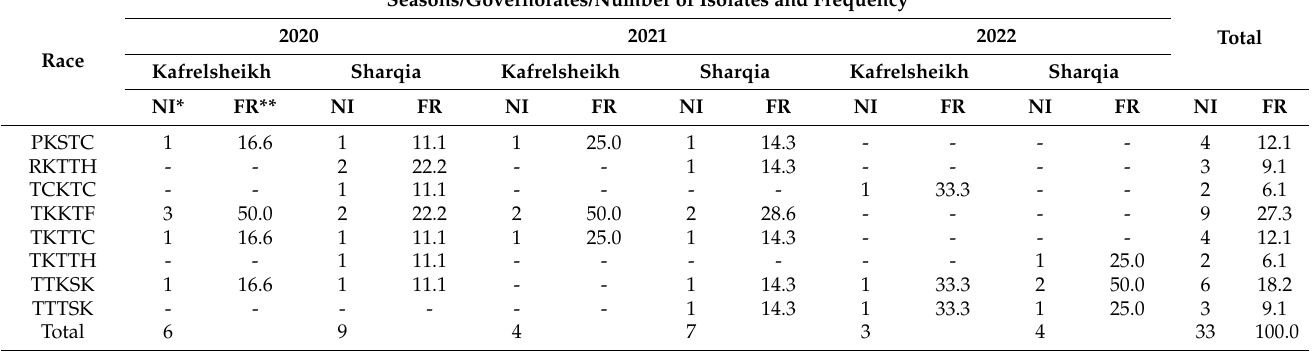
Table 6. The number of isolates and frequency of stem rust races identified in Kafrelsheikh and Sharqia governorates during the three growing